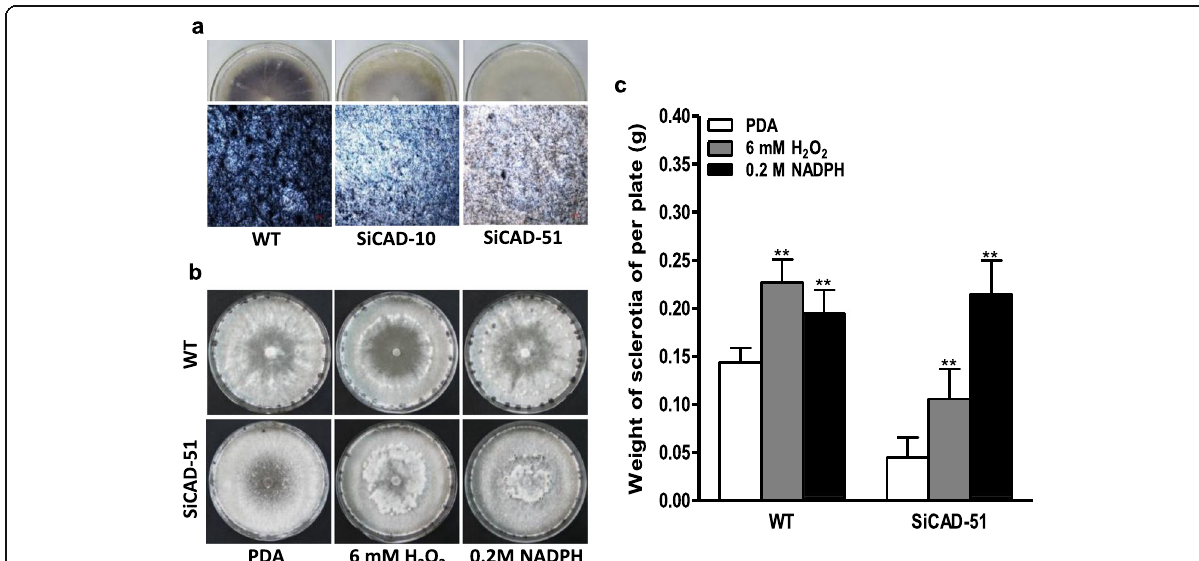
Fig. 3 Ss-CAD -silenced transformants showing reduced superoxide accumulation. Exogenous H 2 O 2 and NADPH treatments restored sclerotial development in Ss-CAD -silenced transformants. a NBT staining was used to detect superoxide accumulation at 3 – 4 dpi on PDA. Staining intensity was monitored under a light microscope, and blue staining represented superoxide accumulation. Ss-CAD -silenced transformants accumulated less blue formazan than the wild-type strain EP-1PNA367. b Treatment with exogenous H 2 O 2 and NADPH recovered sclerotial development in Ss- CAD -silenced transformants. The effects of adding 6 mM H 2 O 2 and 0.2 mM NADPH individually to PDA on S. sclerotiorum sclerotial development were evaluated. Photographs were taken at 10 dpi. c Weights of sclerotia formed under various culture conditions. Sclerotia produced on each plate were collected, air-dried, and weighed at 15 dpi. Three independent replicates were performed for each experiment. Values are means ± S.E. ** P < 0.01; one-way